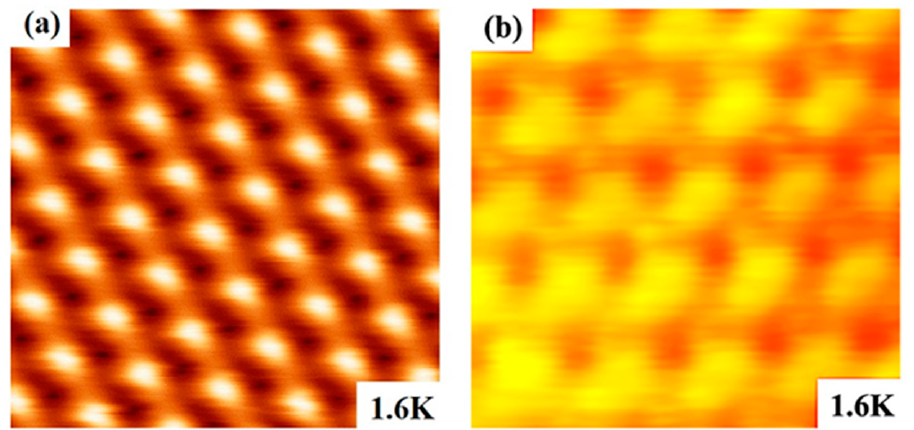
Figure 5. ( a ) Atomic-resolution STM image of HOPG obtained at 1.6 K. Scan area = 1.4 nm × 1.4 nm, bias voltage = + 200 mV, and average tunneling current = 10 nA. ( b ) Atomic-resolution STM image of NbSe 2 obtained at 1.6 K. Scan area = 1.2 nm × 1.2 nm, bias voltage = + 100 mV, and average tunneling current = 5 nA.